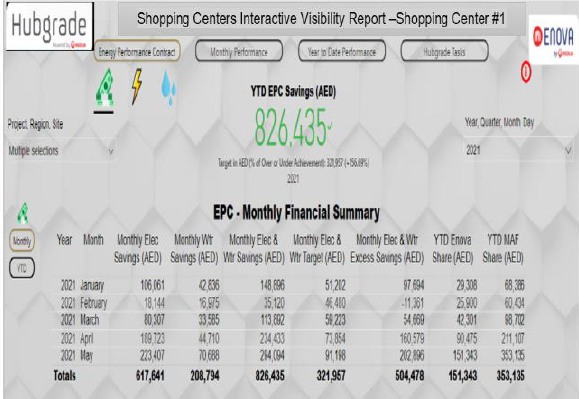
Figure 4: Summary of energy consumption results for selected shopping centres